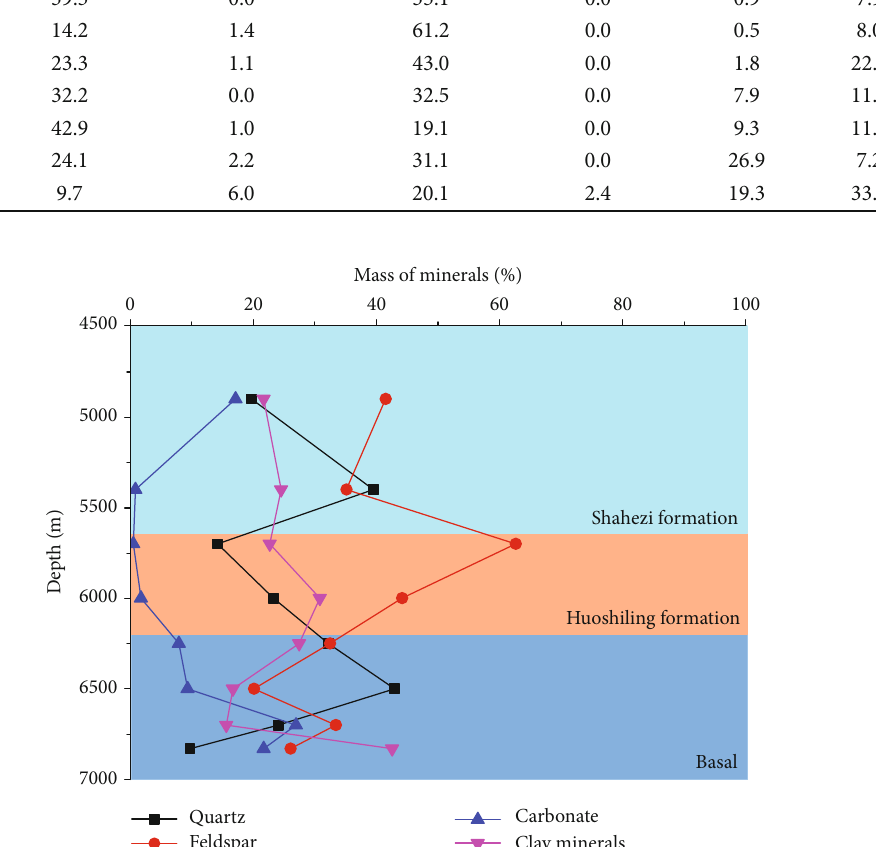
Figure 4: Variation of di ff erent minerals with